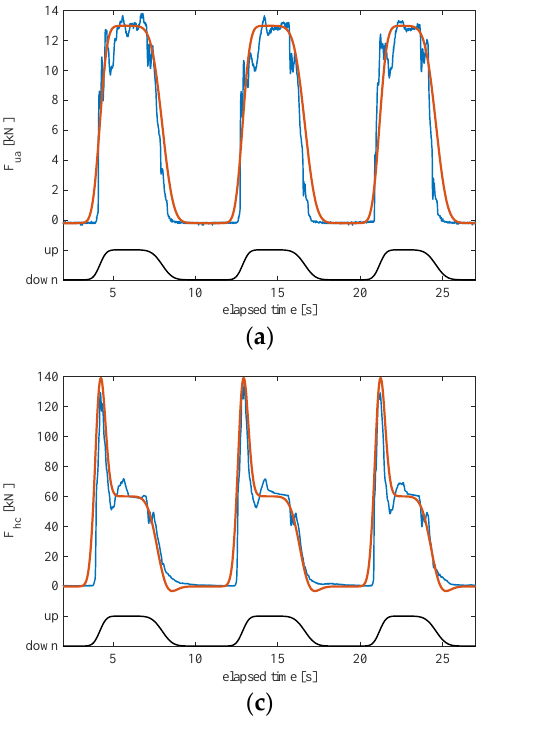
Figure 9. Comparison between experimental and simulated force profile during implement manoeu- vring. ( a ) Force at the upper arm; ( b ) force at the lower link points, horizontal component; ( c ) force at the hydraulic lift